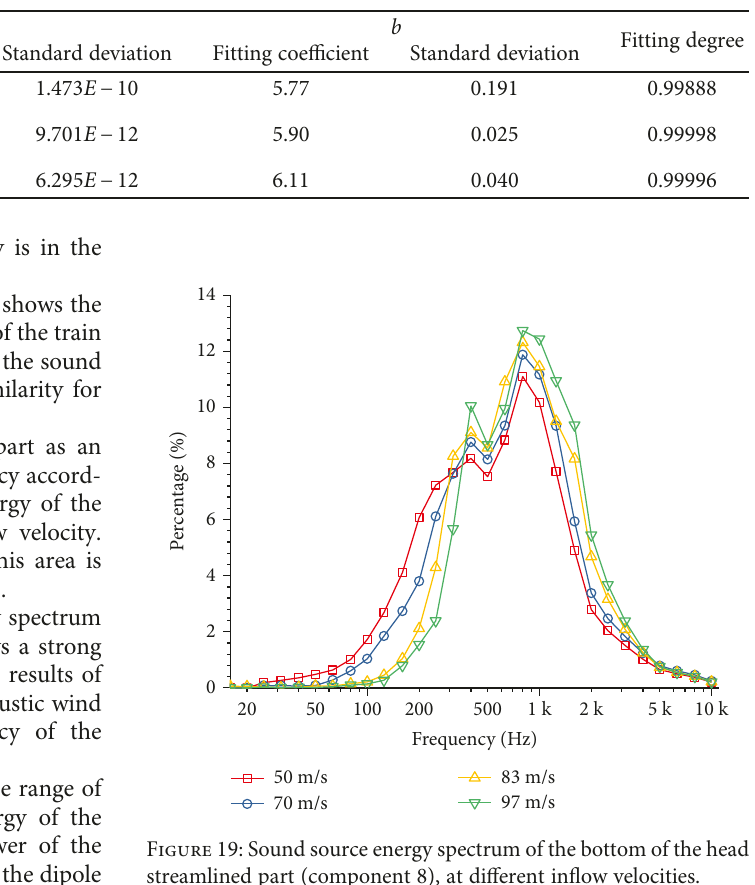
Table 1: Fitting coe ffi cients between the sound source energy and the in fl ow velocity.